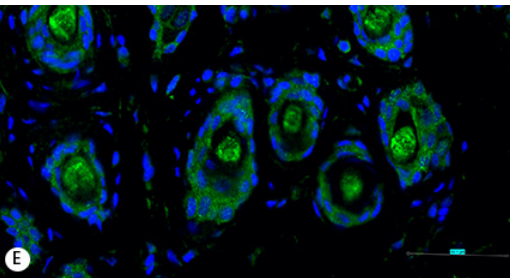
Figure 4. Immunofluorescence detection of HIF-1a, HIF-2a, HIF-3a, HSP27, and HOCX13 in secondary hair follicles of Tibetan cashmere goats. ( A ) HIF-1a is visible in inner root sheath and hair shaft. ( B ) HIF-2a immunostaining in outer root sheath and inner root sheath. ( C ) HIF-3a immunostaining in outer root sheath. ( D ) HSP27 is visible in outer root sheath, inner root sheath, and hair shaft. ( E ) HOCX13 is visible in outer root sheath and hair shaft. ( A – E ) 400×.